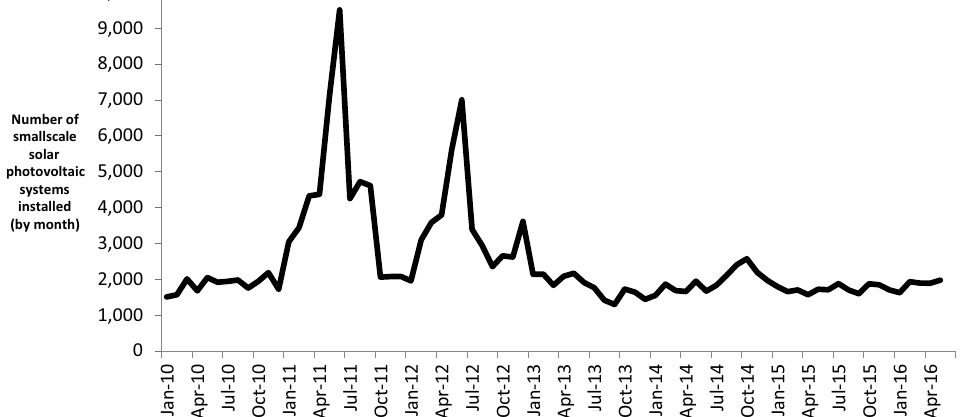
Fig. 1. Number of smallscale solar photovoltaic systems installed in Western Australia, indicating that installation rates have not returned to peaks experienced during